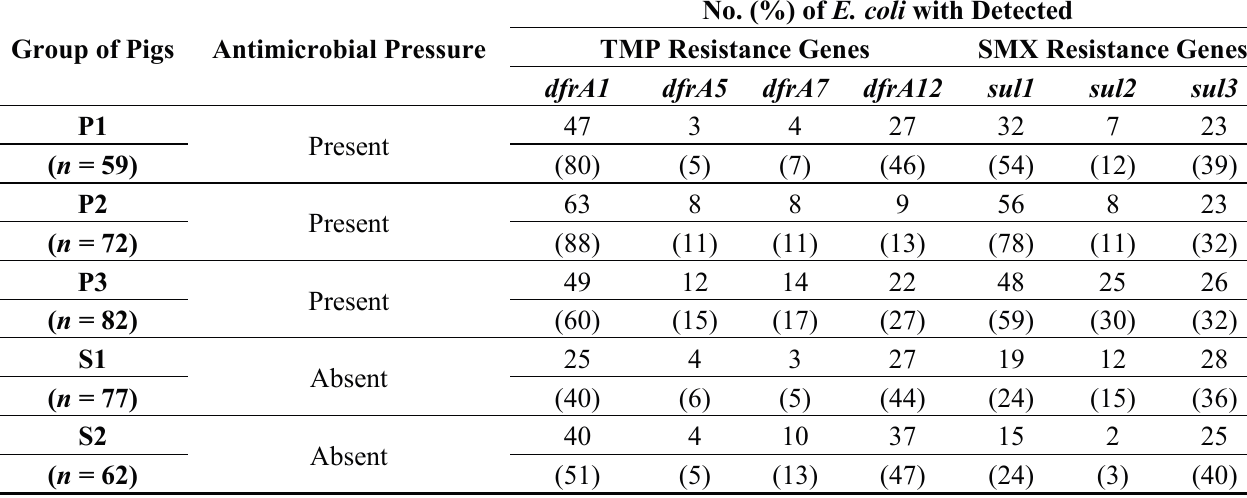
Table 2. Prevalence of trimethoprim and sulfamethoxazole resistance genes in E. coli isolated from groups of pigs during metaphylaxis and in post-exposure period. Group of Pigs Antimicrobial Pressure